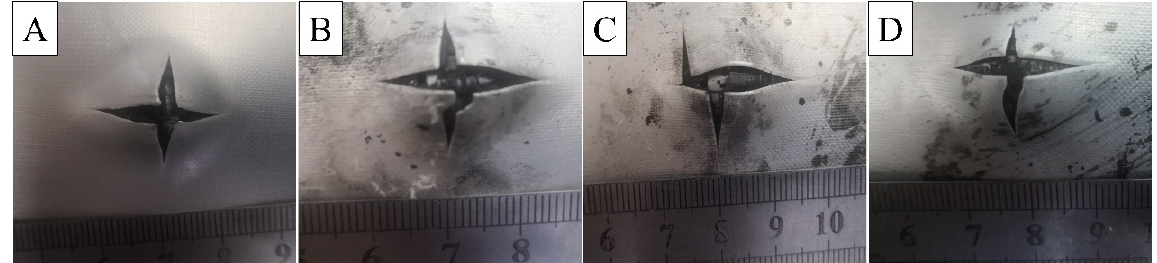
Figure 16. Impact failure morphology of different laminates. ( a ) laminates A. ( b ) laminates B. ( c ) laminates C. ( d ) laminates D.